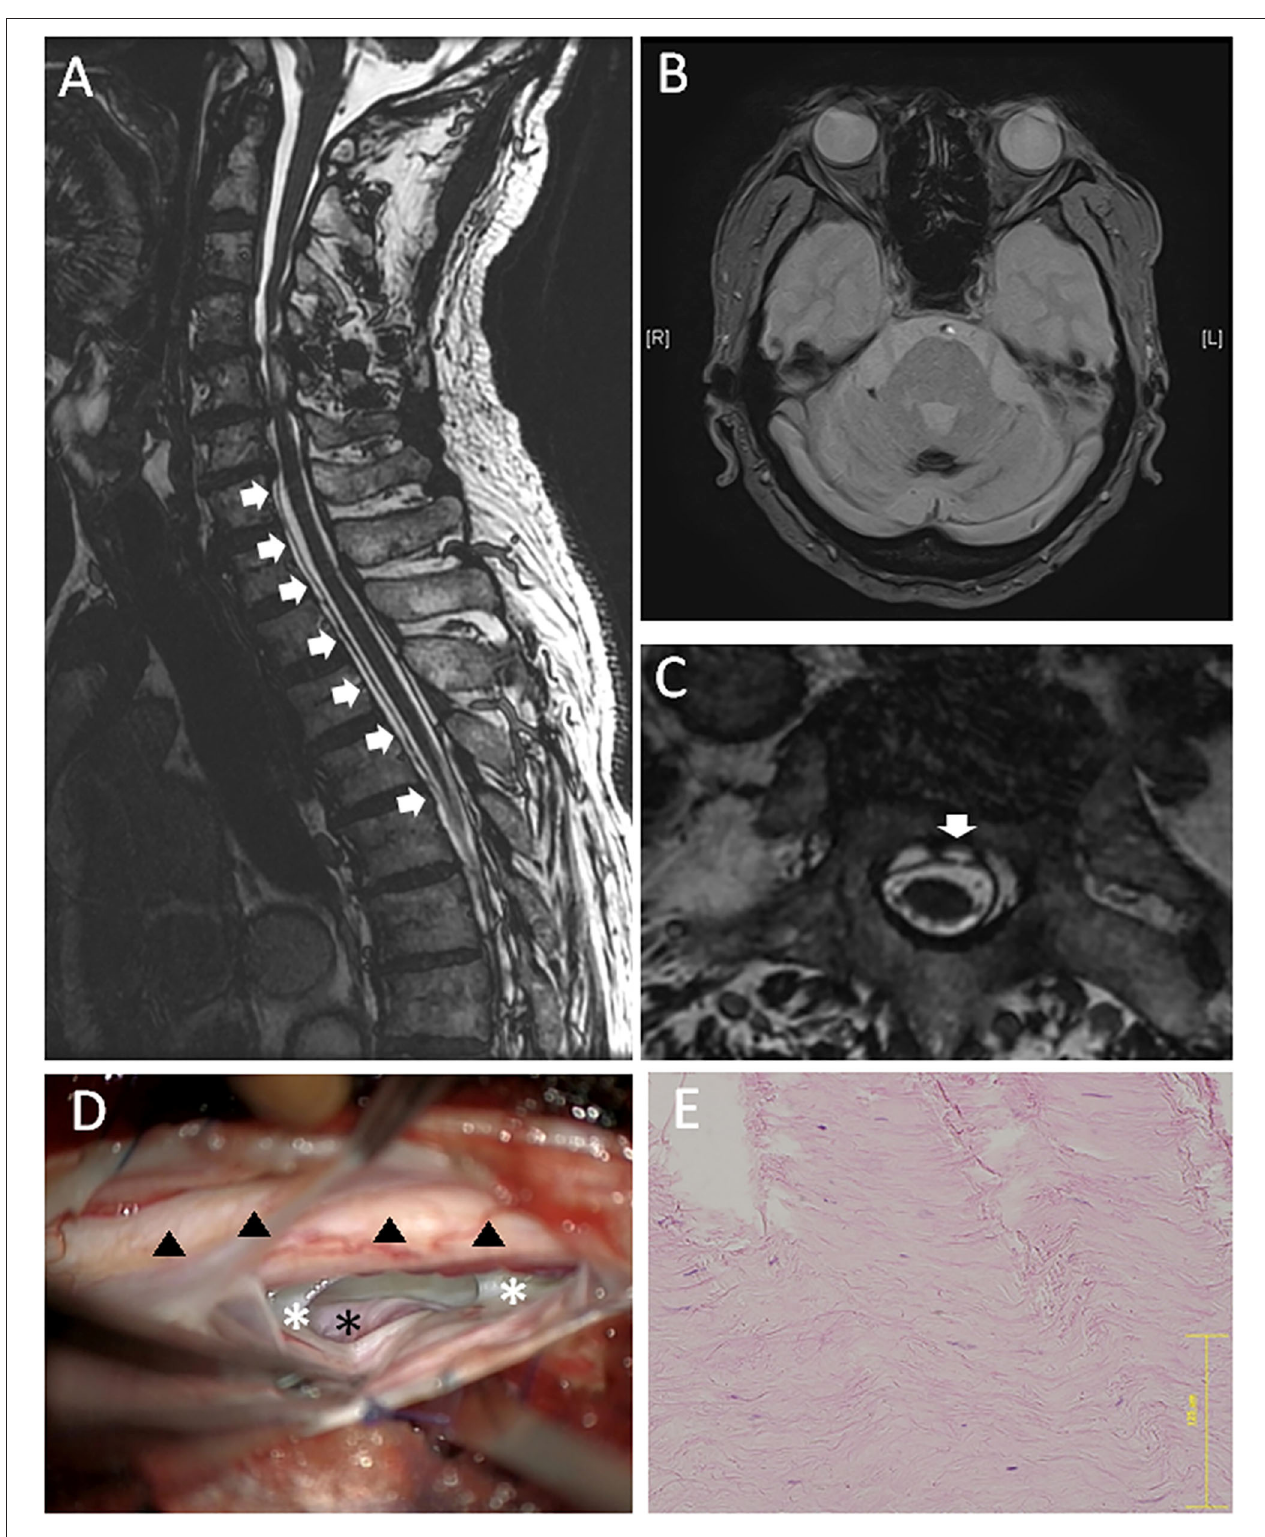
FIGURE 3 | A 79-year-old male (case 3). (A) Sagittal MRI showed VFCC from C7 to T7 in the spinal canal (white arrows). (B) Brain MRI showed a hemosiderin deposition at the sulcus. (C) An axial FIESTA image at the T2 level demonstrated a defect located at the left paramedian anterior dura (the white arrow). (D)